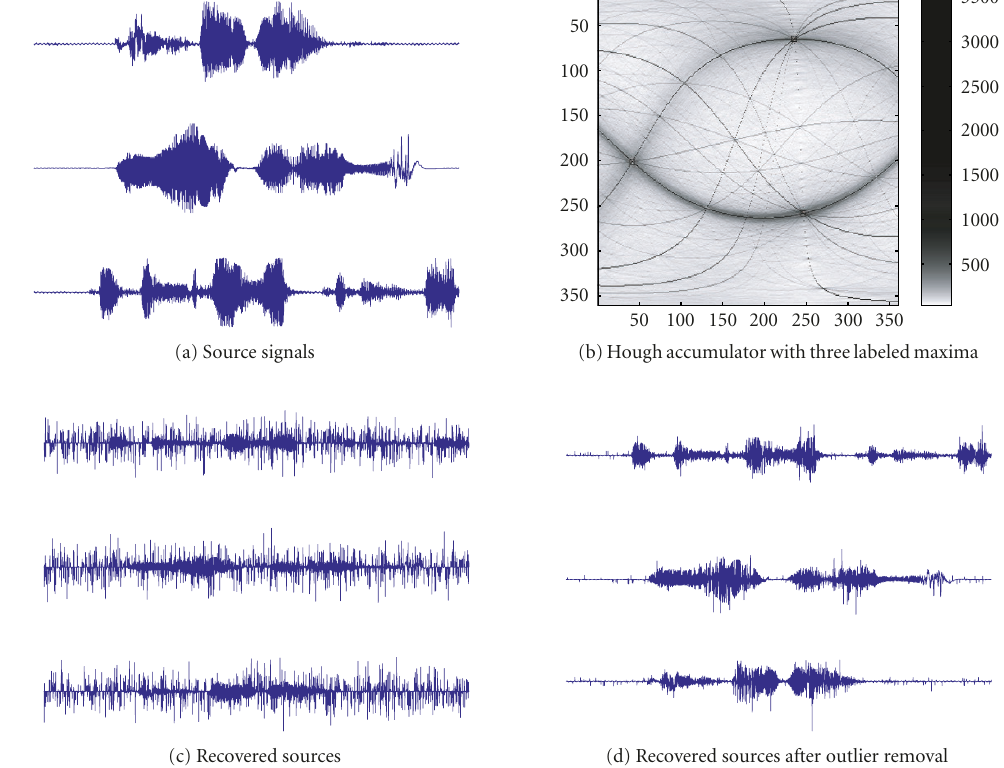
Figure 7: Application to speech signals: (a) shows the original speech sources (“peace and love,” “hello, how are you,” and “to be or not to be”), and (b) the Hough accumulator when trained to mixtures of (a) with 20% outliers. A nonlinear gray scale γ new : = (1 − γ/ max) 10 was chosen for better visualization. (c) and (d) present the recovered sources, without and with outlier removal. They coincide with (a) up to permutation (reversed order) and